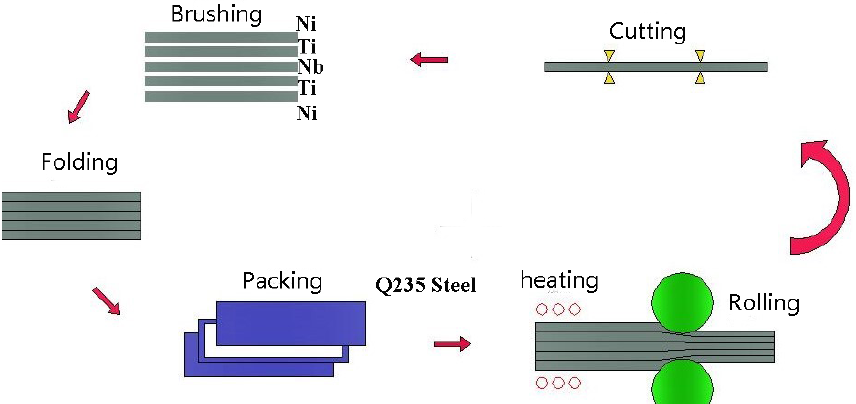
Figure 2. Schematic of the accumulative pack-roll bonding.